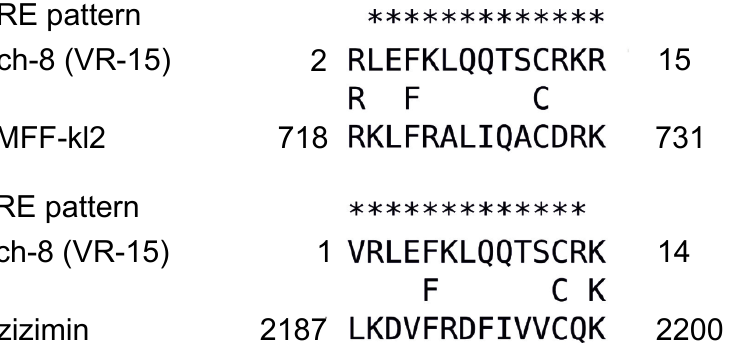
Figure 2. The PHI BLAST search results with the chemerin-8 (VR-15) peptide used as a query and MFF-kl2 (alignment score—3.4 bits; E-value—13; sequence identity—21%) and Zizimin (alignment score—3.1 bits; E-value—21; sequence identity—21%). Chemerin 8 (VR-15) is a 15-aa fragment of the human chemerin spanning from V66 to R80.